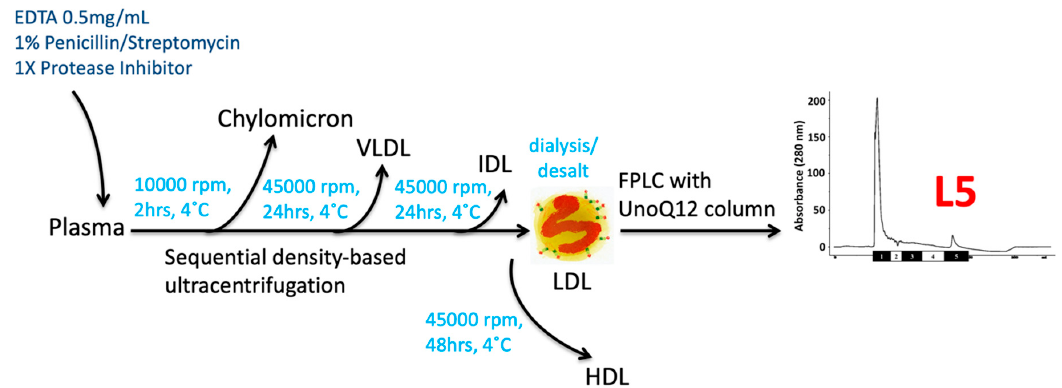
Figure 1. Schematic procedures of L5 LDL isolation. EDTA, antibiotics, and protease inhibitors are materials for the prevention of protein degradation. Samples undergo sequential density-based ultracentrifugation (10,000 rpm at 4 °C for 2 h; d = 1.004, 45,000 rpm at 4 °C for 24 h; d=1.019, 45,000 rpm at 4 °C for 24 h; d=1.063, 45,000 rpm at 4 °C for 48 h), and after that, LDL (d = 1.019~1.063) can be purified. Additional three times dialyzed against TRIS/EDTA buffer at pH 8.0 and later sterilized by 0.22 µm filter, the LDL sample can be further isolated into five subfractions by a fast-protein liquid chromatography (FPLC) system equipped with an UnoQ12 column. L5 LDL is the most electronegative subfraction. VLDL: very-low-density lipoprotein; IDL: intermediate-density lipoprotein; LDL: low-density lipoprotein; HDL: high-density lipoprotein; L5: electronegative LDL; FPLC: fast-protein liquid chromatography; rpm: revolutions per minute; 1× Protease Inhibitor: cOmplete™ (Roche Diagnostics, Basel, Switzerland).